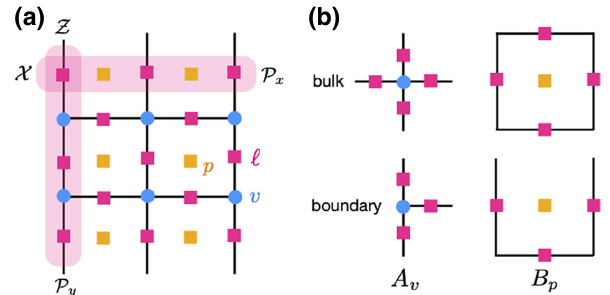
FIG. 1. A depiction of the main example qubit system. (a) The square lattice of size ( L x , L y ) = ( 2, 3 ) with “gauge” qubits on its links (cid:2) (magenta squares) and “matter” qubits on its vertices v (blue circles) and on its plaquettes p (yellow squares). Also (cid:5) shown are the logical- X operator X = (cid:5) (cid:2) ∈ P x X (cid:2) and the logical- Z operator Z = (cid:2) ∈ P y Z (cid:2) , each acting on a specific subset of links, i.e., for the logical- X operator X , this subset consists of all dangling links on one of the rough boundaries as indicated by the (horizontal) path P x , while for the logical- Z operator Z , the respective subset is made up of all links on one of the smooth boundaries, i.e., the vertical path P y . (b) The operators A v and B p acting on a vertex and a plaquette in the bulk and at the boundary,